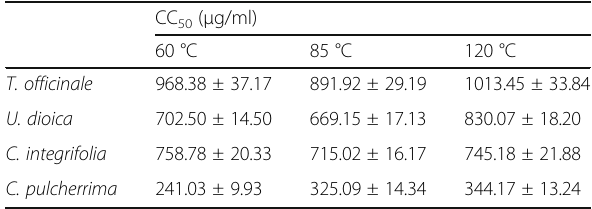
Table 2 Cytotoxic concentration 50 (CC 50 ) of the methanolic extracts to 60, 85 and 120